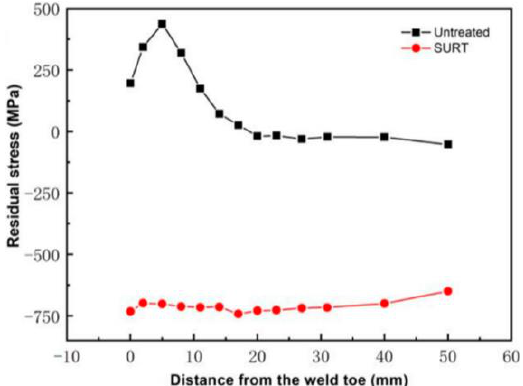
Figure 13. Variation of the residual stress of T4003 ferritic SS welded joint before and after USRP. Reprinted with permission from ref. [48]. Copyright 2020 MDPI.